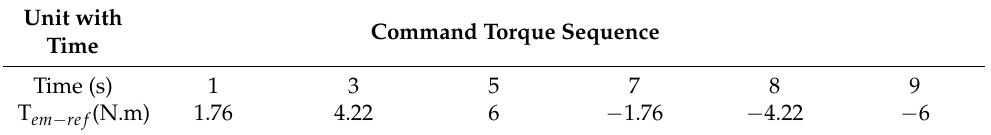
Table 2. Reference torque to test the combined algorithm over a wide range of torque operations. Unit with Command Torque Sequence Time Time (s) 1 3